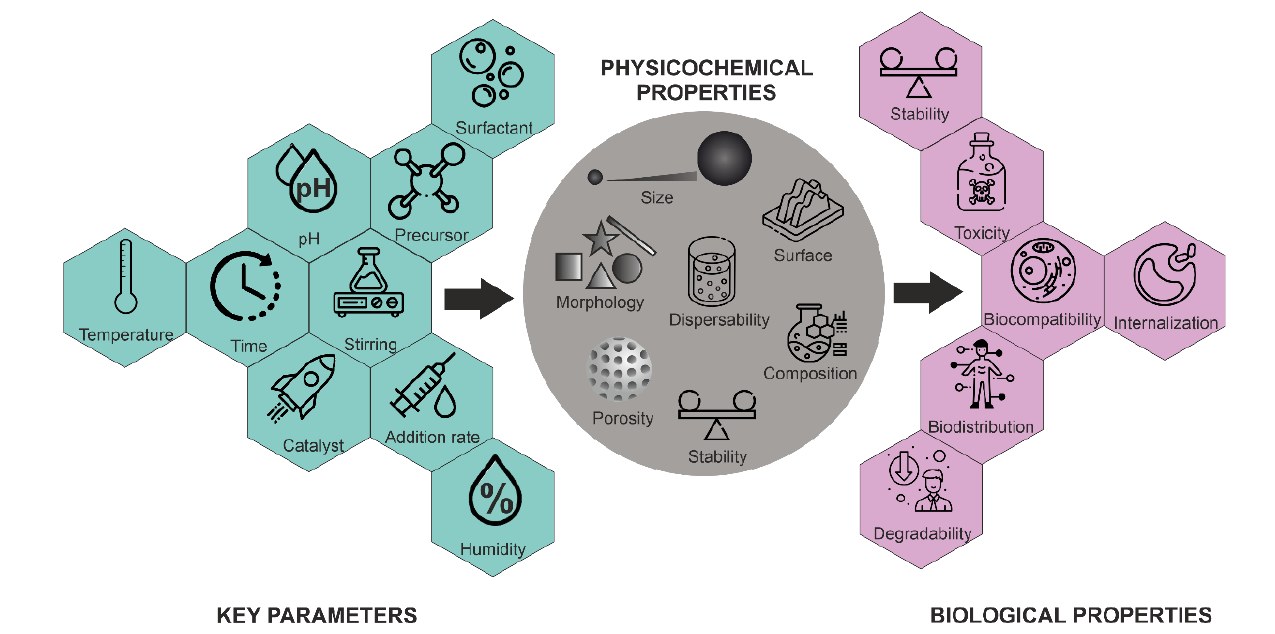
Figure 5. Influence of key parameters on the physico-chemical and biological properties of MSNs. pH